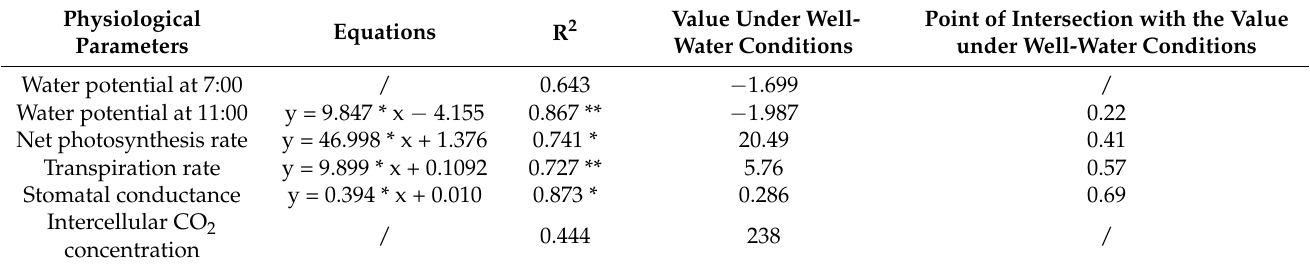
Table 2. Relationship between the water content and physiological indices for spring when the available water content was less than